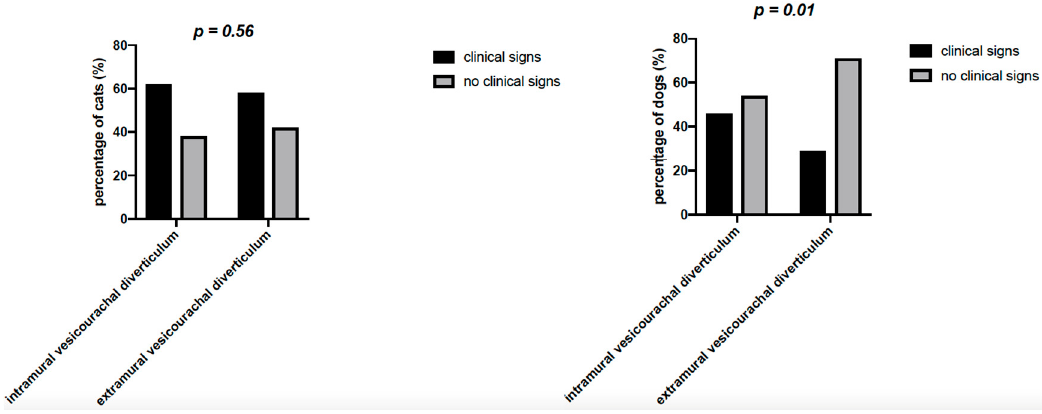
Figure 6. Chi squared test of the percentage of cats and dogs with clinical signs and without clinical signs, for both intramural and extramural vesicourachal diverticulum.